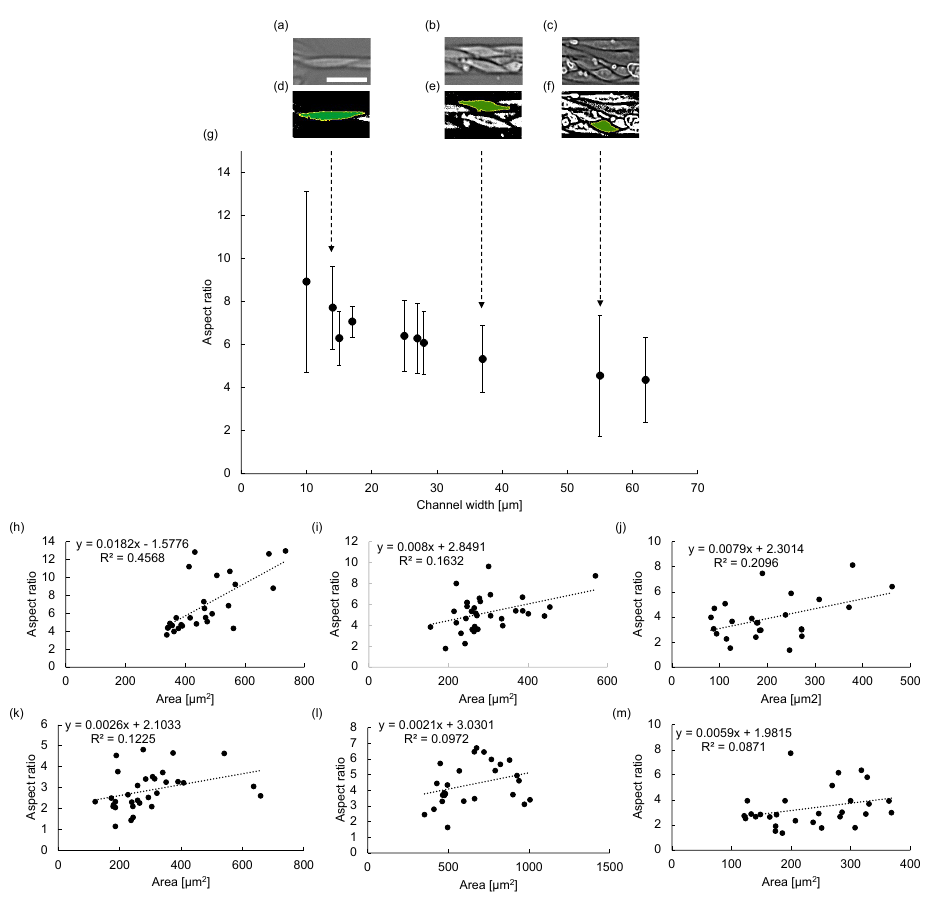
55 µm (Figure 5j) demonstrate stronger correlation between the aspect ratio and the size of cells in narrower micorochannels.